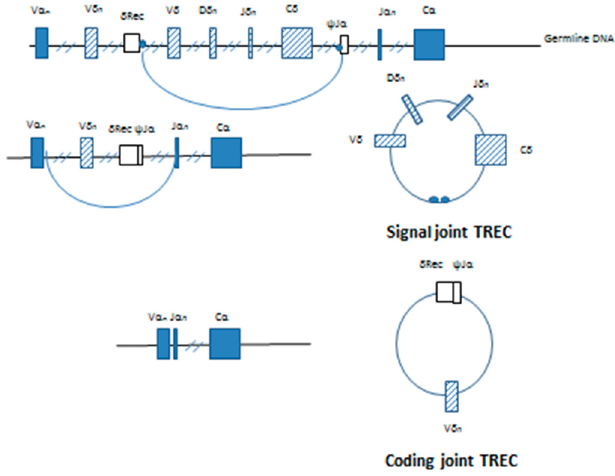
Figure 2. Generation of signal and coding joint TRECs in developing T lymphocytes. Initial splicing and ligation of the germline DNA results in the removal of most of the TCRD locus from its position within the TCRA locus. Ligation of the signal sequences (small circles) on the ends of the excised DNA produces a signal joint TREC. Further V-J rearrangement of the TCRA locus removes the remainder of the TCRD locus and the δ R ec- ψ J α coding joint producing the coding joint TREC. Further rearrangement of the TCRA gene to inactivate the δ locus produces a second TREC, and occurs almost immediately [13]. Removal of the δ Rec/ ψ J α coding joint from the germline DNA and subsequent joining V α and J α segments produces a functional α TCR [14]. The excised DNA forms the coding joint or δ Rec/ ψ J α TREC containing the V α - J α signal joint (Figure 2). Quantitative